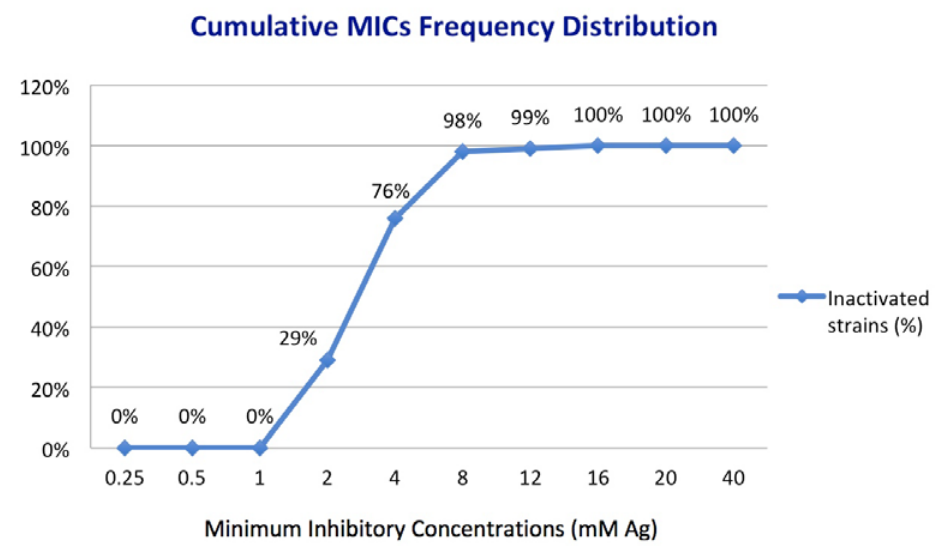
Figure 5. Cumulative distribution of MICs frequency for 100 clinical isolates based on the concentration of Ag as an active element of AgNPs.